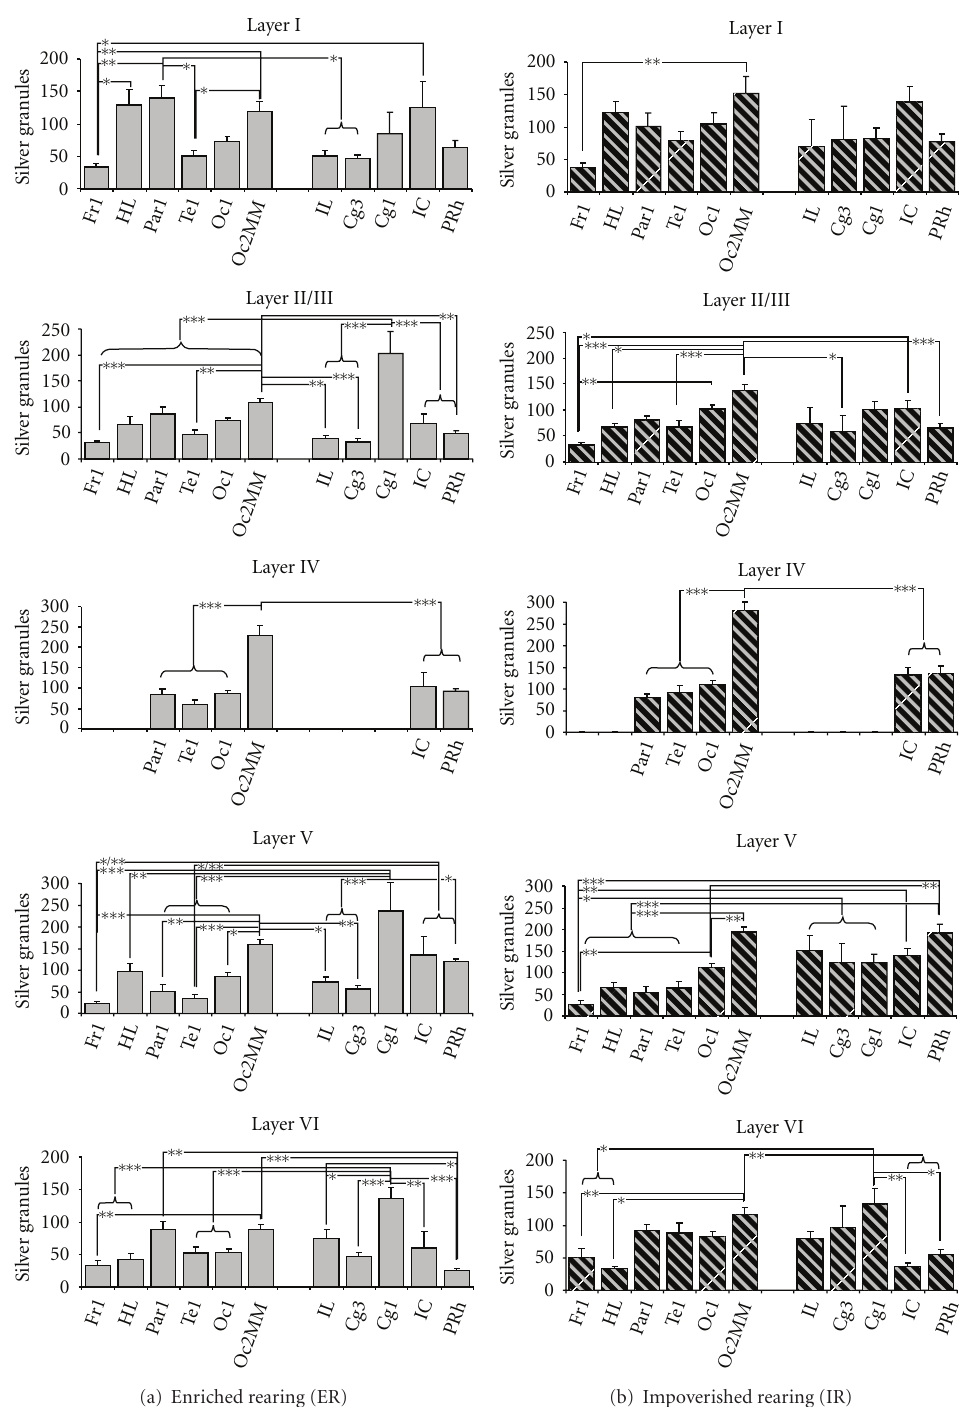
Figure 4: Silver granule densities in the cortical layers of motor (Fr1, HL), sensory (Par1, Te1, Oc1, Oc2MM), and prefronto-limbic areas (IL, Cg3, Cg1, IC, PRh) in enriched- (a) and impoverished-reared (b) gerbils. Note that considerable layer- and area-dependent di ff erences can be seen. Data are given as mean + standard error. Asterisks indicate levels of significance according to posthoc analysis of variance (ANOVA) testings including all areas. ∗ : P < . 05, ∗∗ : P < . 01, ∗∗∗ : P < . 001. Fr1 : frontal cortex area 1; HL : hindlimb area; Par1 : parietal cortex area 1; Te1 : temporal cortex area 1; Oc1 : occipital area 1; Oc2MM : occipital cortex area 2 mediomedial; IL : infralimbic cortex; Cg3 : cingular cortex area 3; Cg1 : cingular cortex area 1; IC : insular cortex; PRh : perirhinal